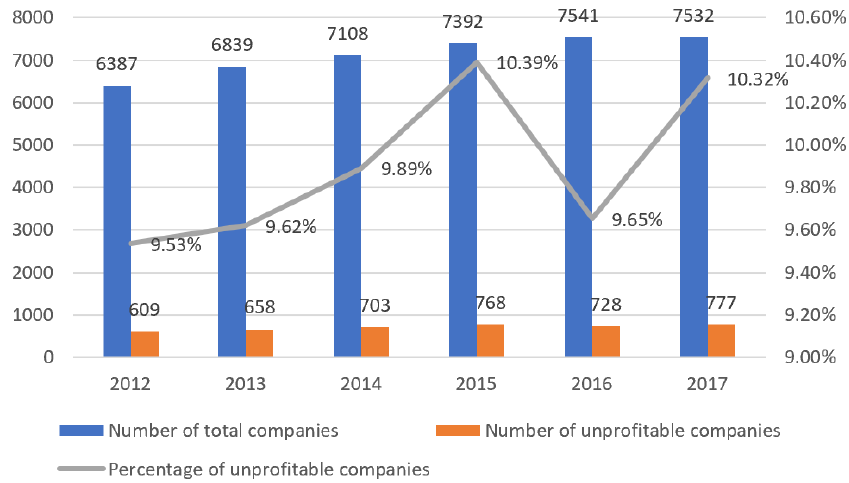
Figure 2. Number of pharmaceutical companies in China. Data resource: China National Bureau of Statistics, http://www.stats.gov.cn.